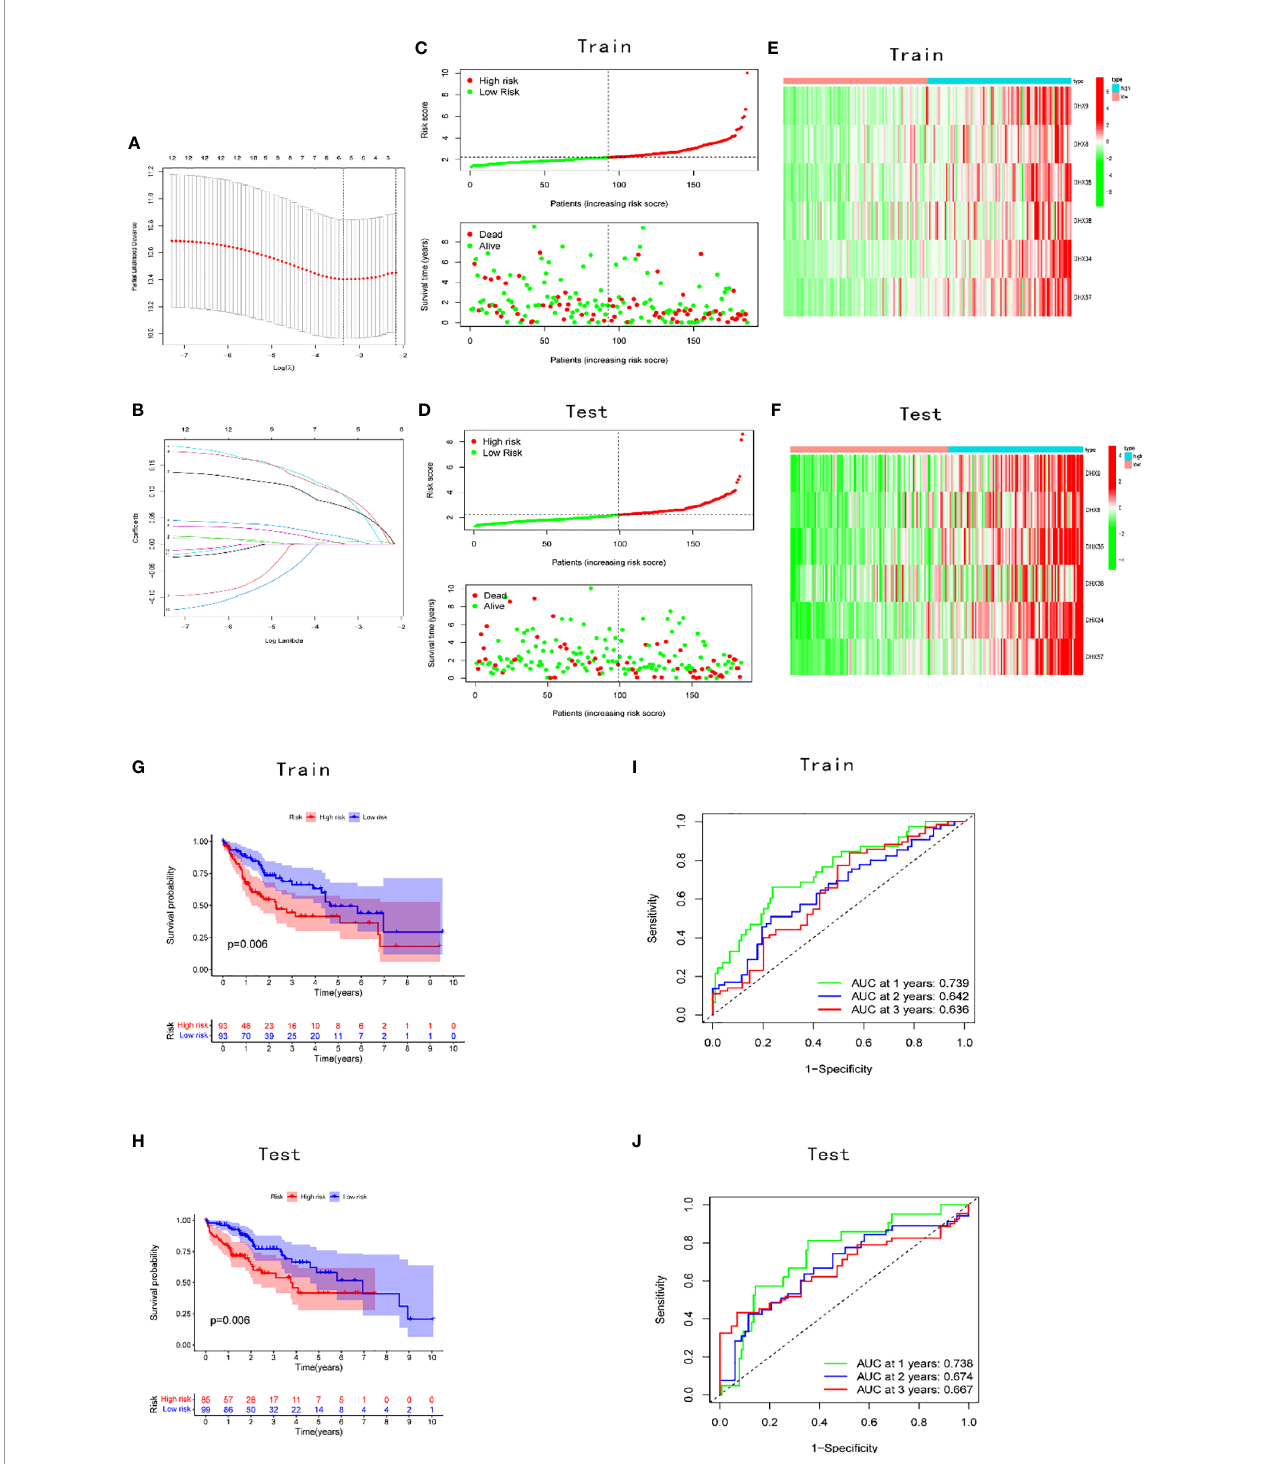
FIGURE 3 | Construction and validation of the prognostic signature. (A) Construction of the LASSO regression model. The optimal log l value is shown as a vertical dotted line. (B) The LASSO coef fi cient pro fi le of DEAH-box RNA helicases, with each line representing an independent DEAH-box RNA helicase. Distribution of risk scores and prognostic status in the (C) training and (D) validation cohorts. Expression levels of the six genes in the (E) training and (F) test cohorts. KM curves in the (G) training and (H) test cohorts. Time-dependent receiver operating characteristic curve of the prognostic model in the (I) training and (J) test